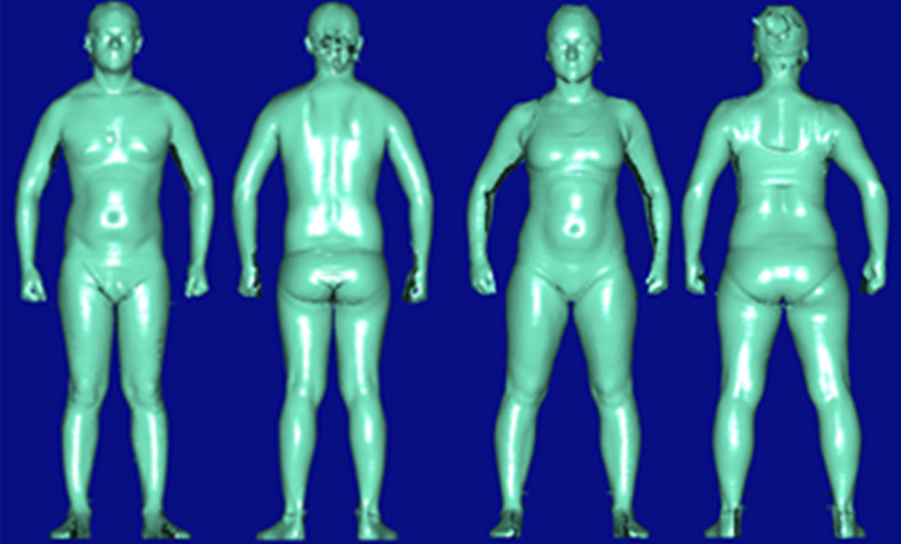
Figure 2. Standard Position (Male: Right; Female: